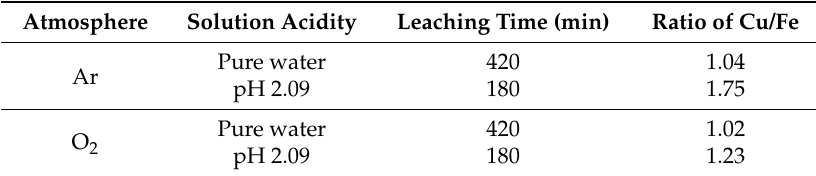
Table 3. Chalcopyrite’s surface atomic ratio (XPS)